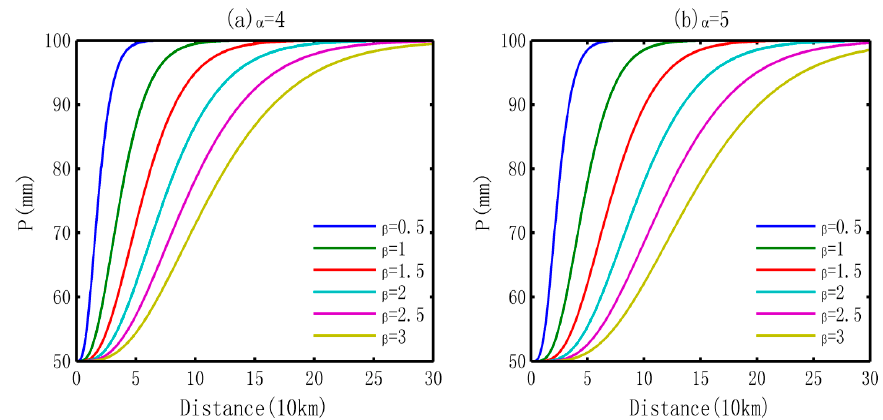
Figure 3. Illustration of precipitation evolution from desert to inner oasis. Assuming the initial precipitation P 0 at the boundary between desert and oasis is 50 mm/year and the zooming constant C is 50, the precipitation evolution is shown with different shape factor and different scale factor.